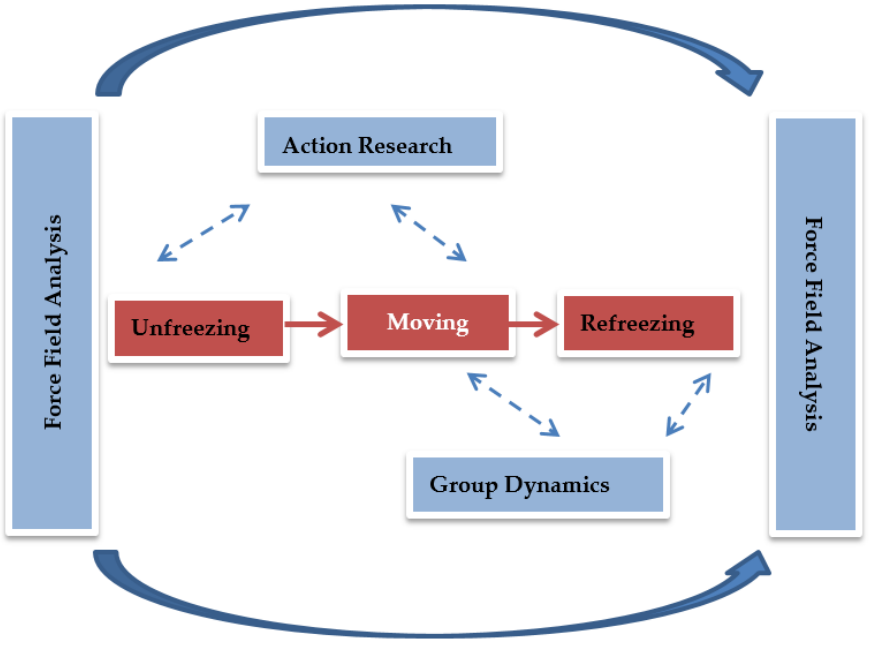
Figure 2. A more accurate view of Lewin’s change model. Reproduced from Rosenbaum et al. (2018).